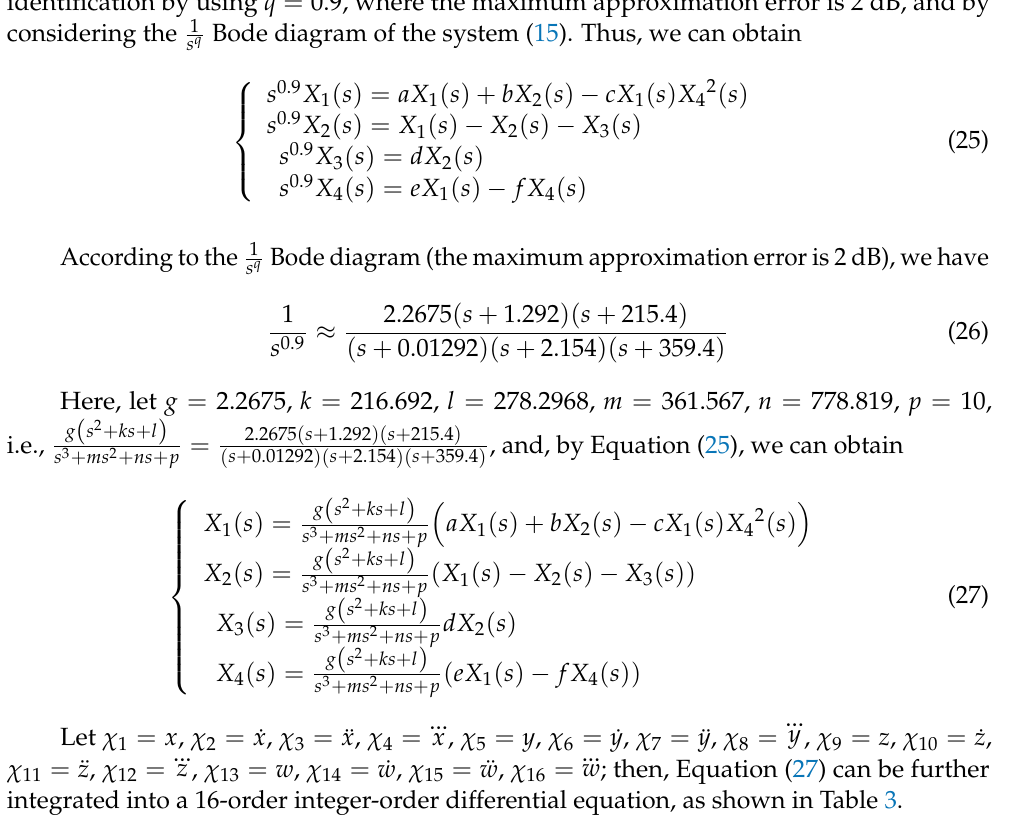
Table 3. Sixteen-order integer-order differential equation of system